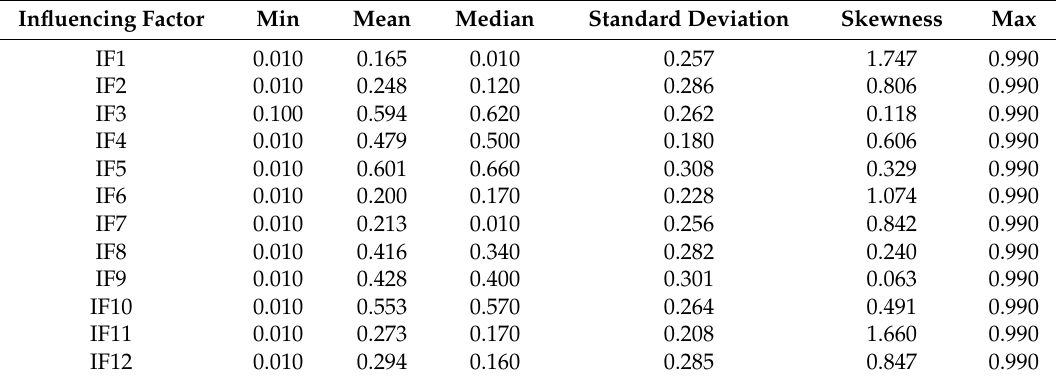
Table 2. Statistical description of the collected